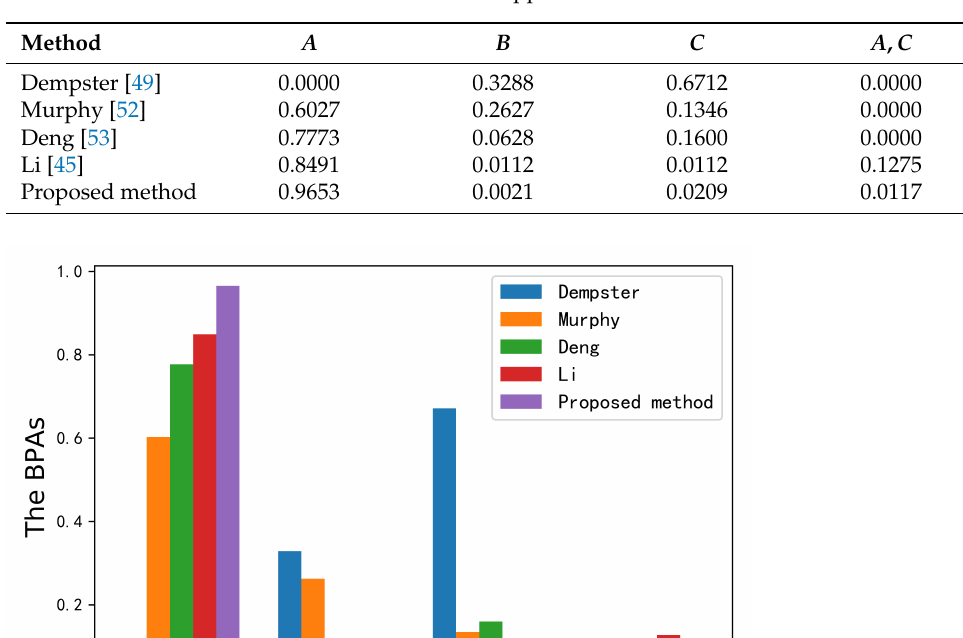
Table 6. Fusion results from different methods in Application 1.